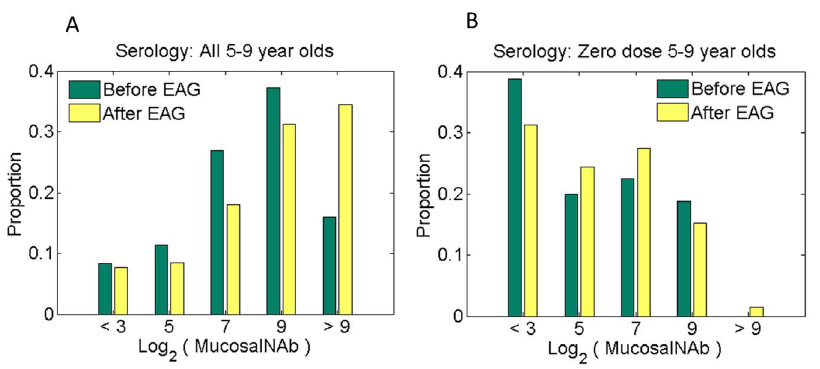
Figure 4. Effect of expanding age groups in SIA campaigns on mucosal immunity. ( A ) Mucosal antibody titer distribution before and after expanded age group campaigns in the overall population (5–9 years) and ( B ) the unvaccinated group (5–9 years) only. log 2 (mucosal antibody titer) , 3 represents high susceptibility to